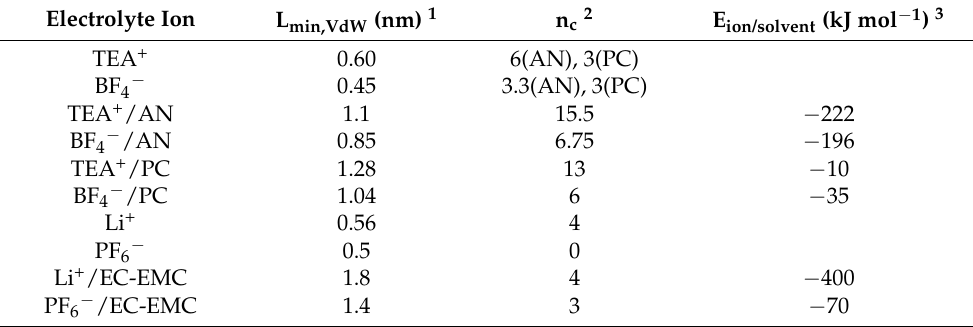
Table 2. Values of parameters of the electrolyte systems used in this study [31,38,62,63]. Electrolyte